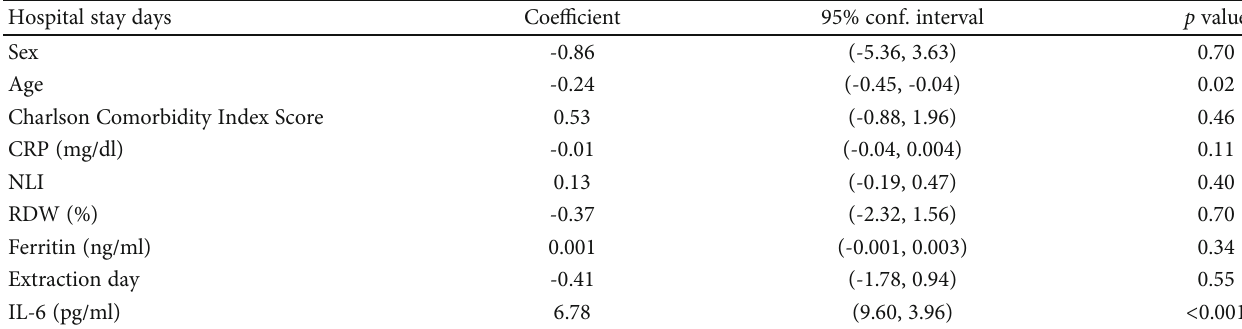
Table 3: Coe ffi cients for hospital stay days adjusted by age, sex, Charlson Comorbidity Index Score, and main analytical values in a linear regression multivariate